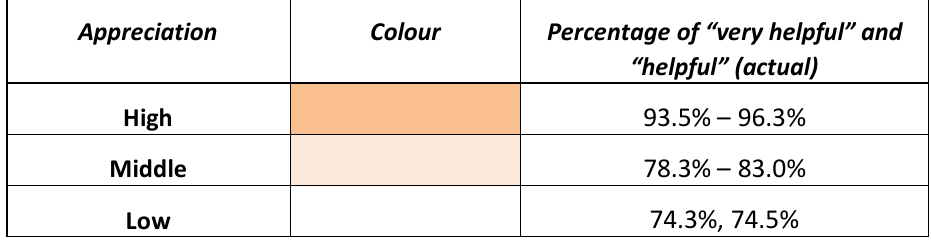
Table 22.1 : Scheme for ranking the ARIADNEplus services based on survey